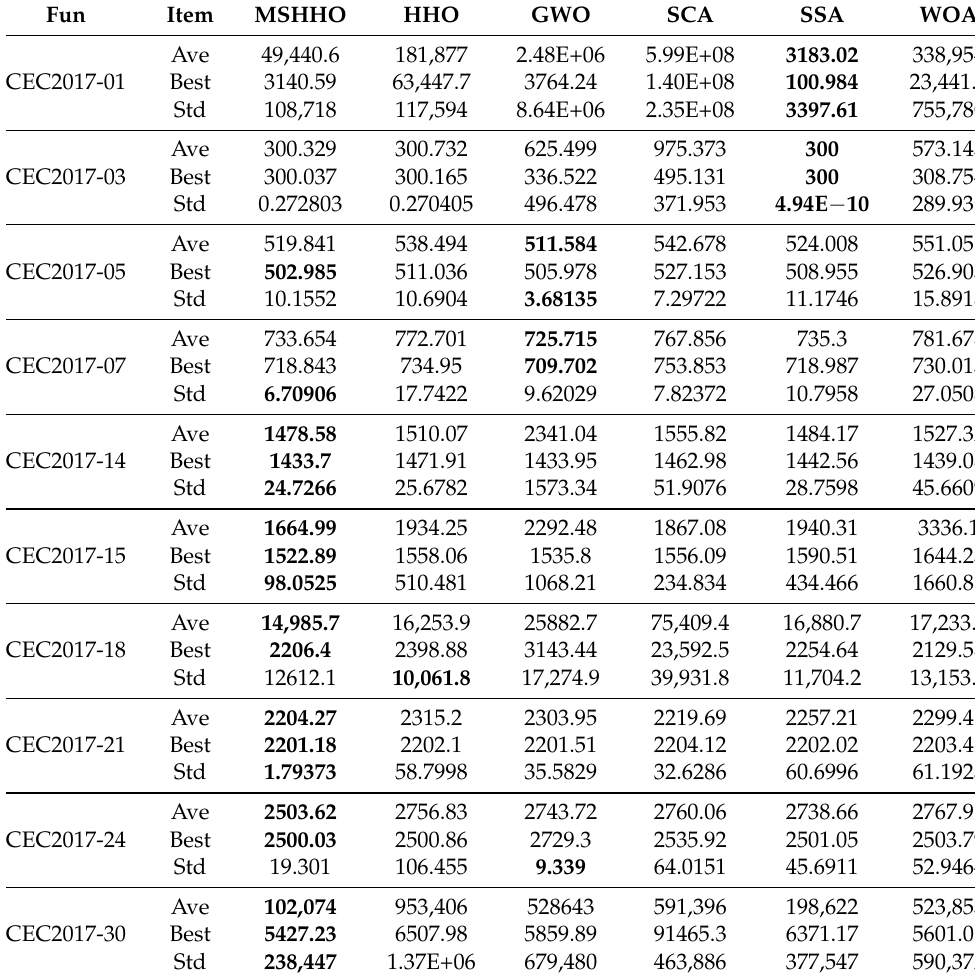
Table 5. Results of CEC2017 benchmark